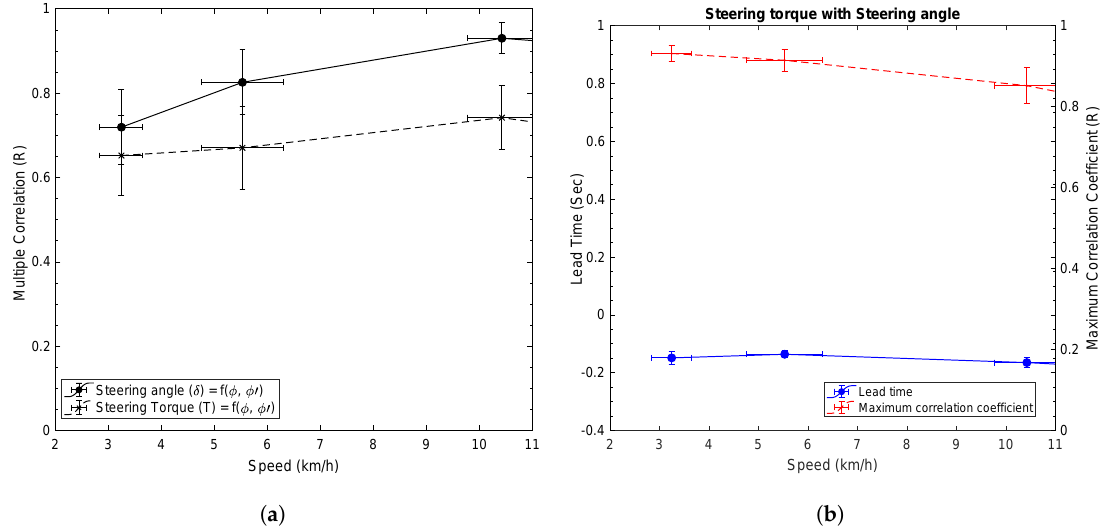
Figure 11. Analyses to select an appropriate input parameter between the steering angle and the steering torque. ( a ) Regression correlation for the steering angle and the steering torque; ( b ) Lead time and MCC (R) for the steering torque with the steering